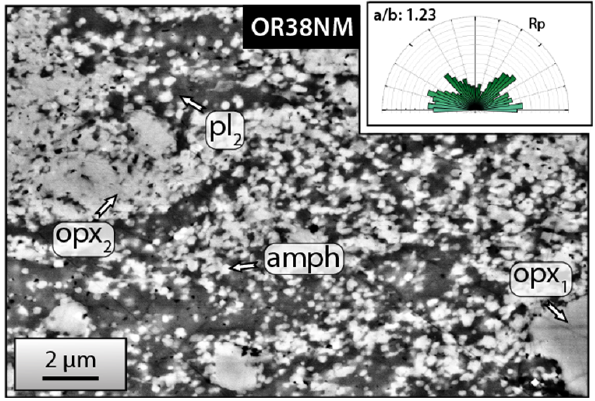
Figure 13. Rose diagram of the SPO of undifferentiated reaction products in fine-grained mixed zones in the Mg-rich opx + plag as- semblages. opx: orthopyroxene, pl: plagioclase, amph: